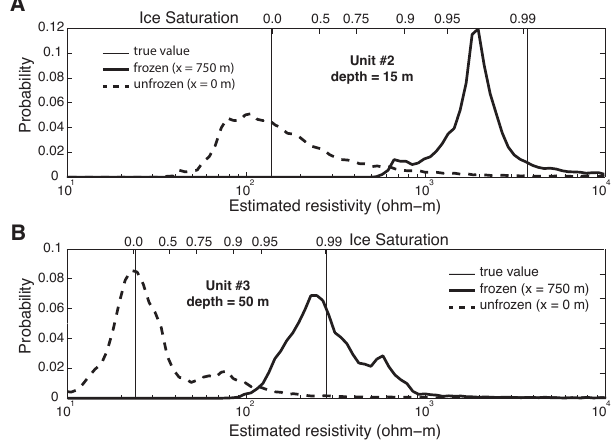
Figure 7. McMC-estimated resistivity posterior distributions within frozen and unfrozen unit 2 gravels (a) and frozen and unfrozen unit 3 silts (b) for the hydrostatic 6m deep lake scenario at 1000 years. Unfrozen resistivity distributions are extracted beneath the center of the lake ( r = 0) at depths of 15 and 50m for the gravels and silts, respectively. Frozen distributions are extracted at the same depths but at r = 750m. The upper x -axis labels indicate approximate ice saturation based on the lithology-dependent ice saturation versus resistivity curves shown in Fig. 2. Table 2. Probability of ice saturation falling above or below spec- ified thresholds based on the McMC-derived resistivity probability distributions shown in Fig. 7.